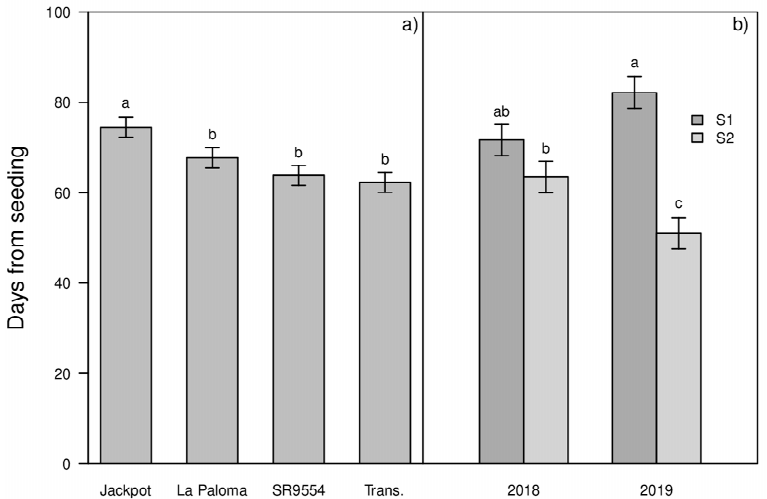
Figure 5. Days from seeding to reach 75% of green cover (DFS) as affected by the main effect of cultivars ( a ) and by the interaction between year and seeding time ( b ). Trans. = Transcontinental. Values with the same letter are not significantly different (Fisher’s protected LSD test at the 0.05 probability level). Vertical bars represent standard errors.